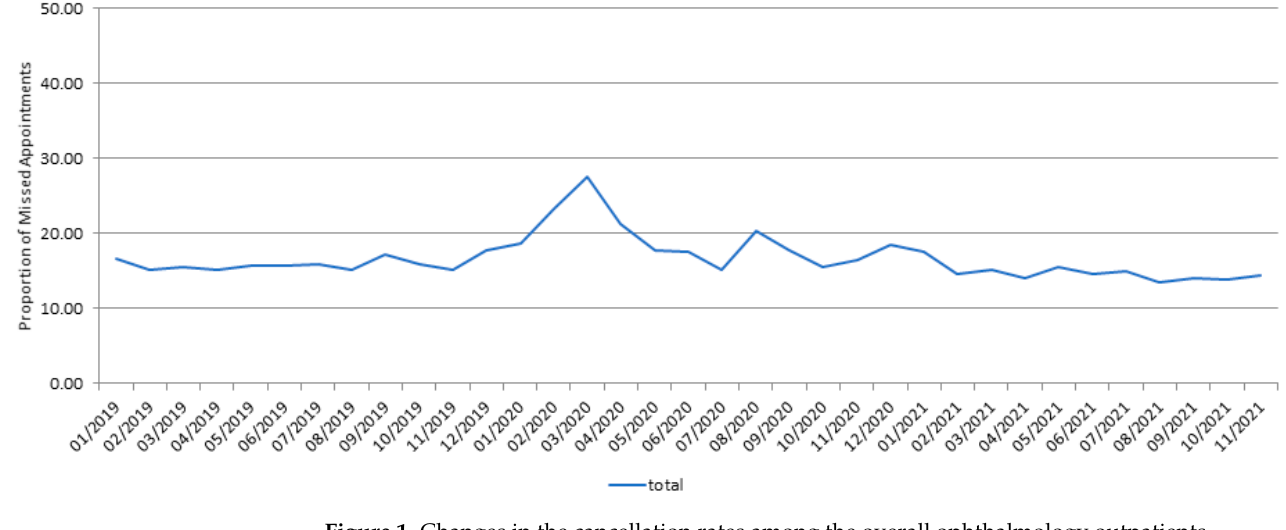
Figure 1. Changes in the cancellation rates among the overall ophthalmology